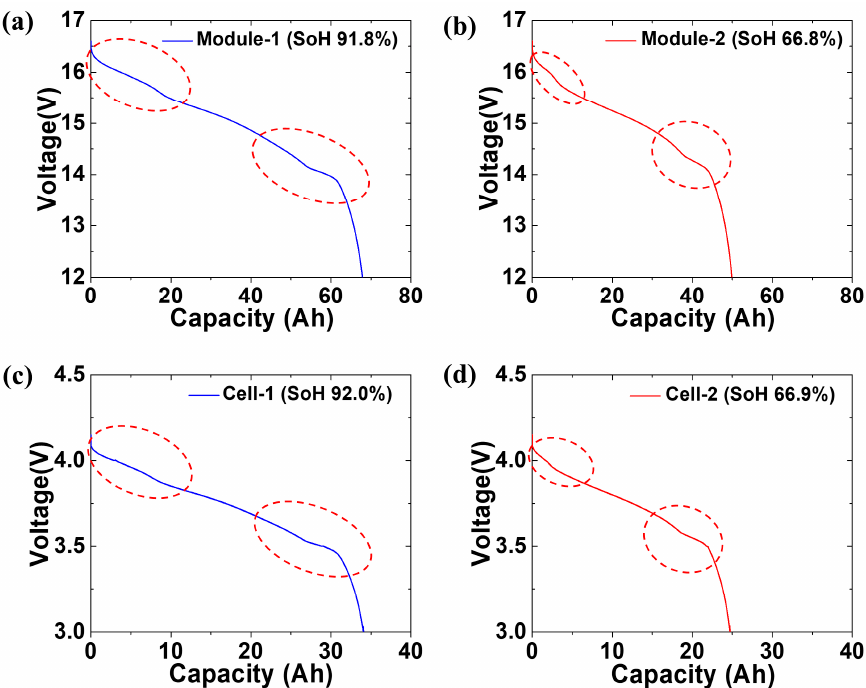
Figure 4. Polarization curves measured during the electrochemical discharge process of ( a ) module- 1, ( b ) module-2, ( c ) cell-1, and ( d ) cell-2. Dotted circles indicate the redox reactions during the dis- charge.